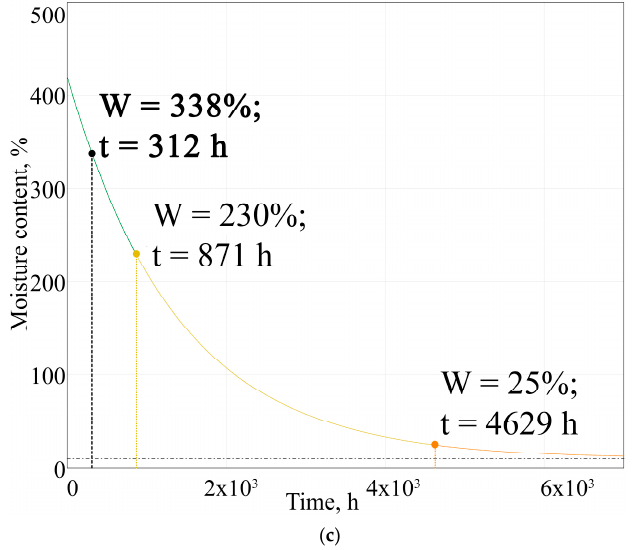
Figure 4. ( a ) Dynamics of change in moisture content of pine snag; ( b ) dynamics of change in moisture content of coarse woody debris; ( c ) dynamics of change in moisture content of forest floor.